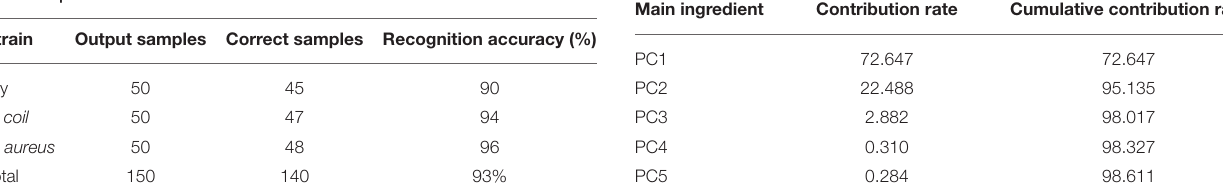
TABLE 2 | Classification results.